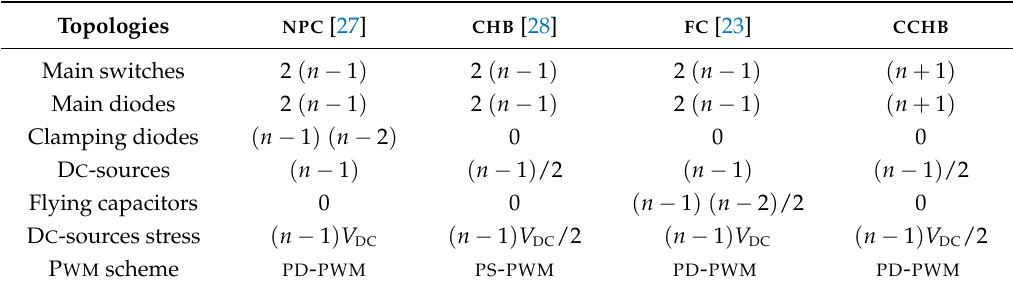
Table 2. Comparison of traditional multilevel inverters with CCHB